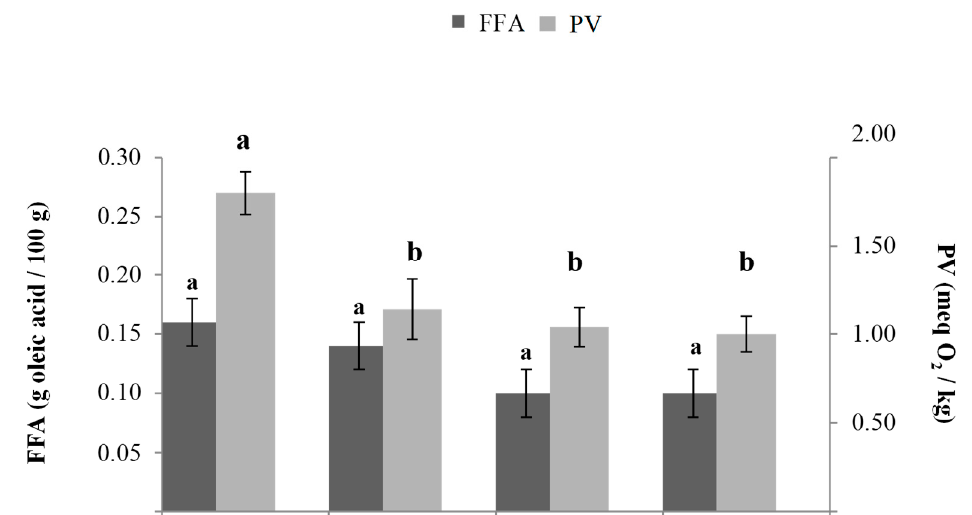
Figure 2. Free fatty acids (FFA) and peroxide values (PV) of the fat blends L, P, V1, and V2 (for identification of the samples see Table 1). a–b: Different letters correspond to statistically significant differences ( p ≤ 0.05) for each parameter.